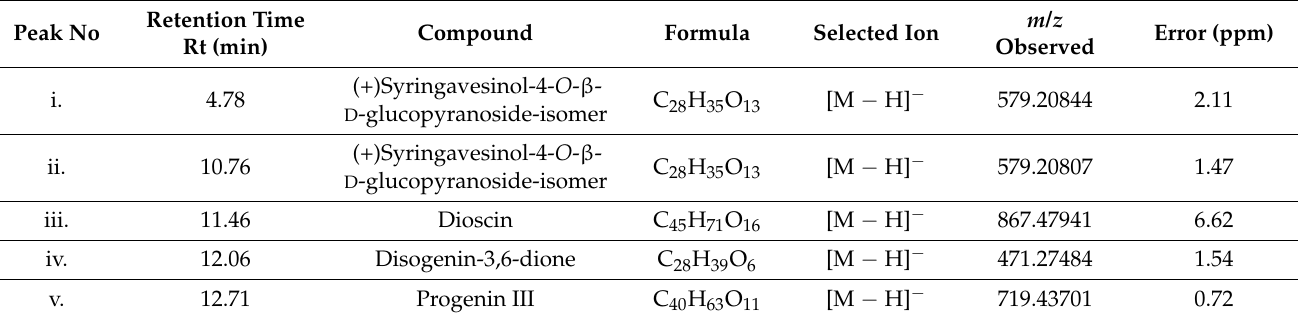
Table 1. Mass spectral characteristic of steroidal saponins determined by LCMS-ESI in the crude extract of D. hispida